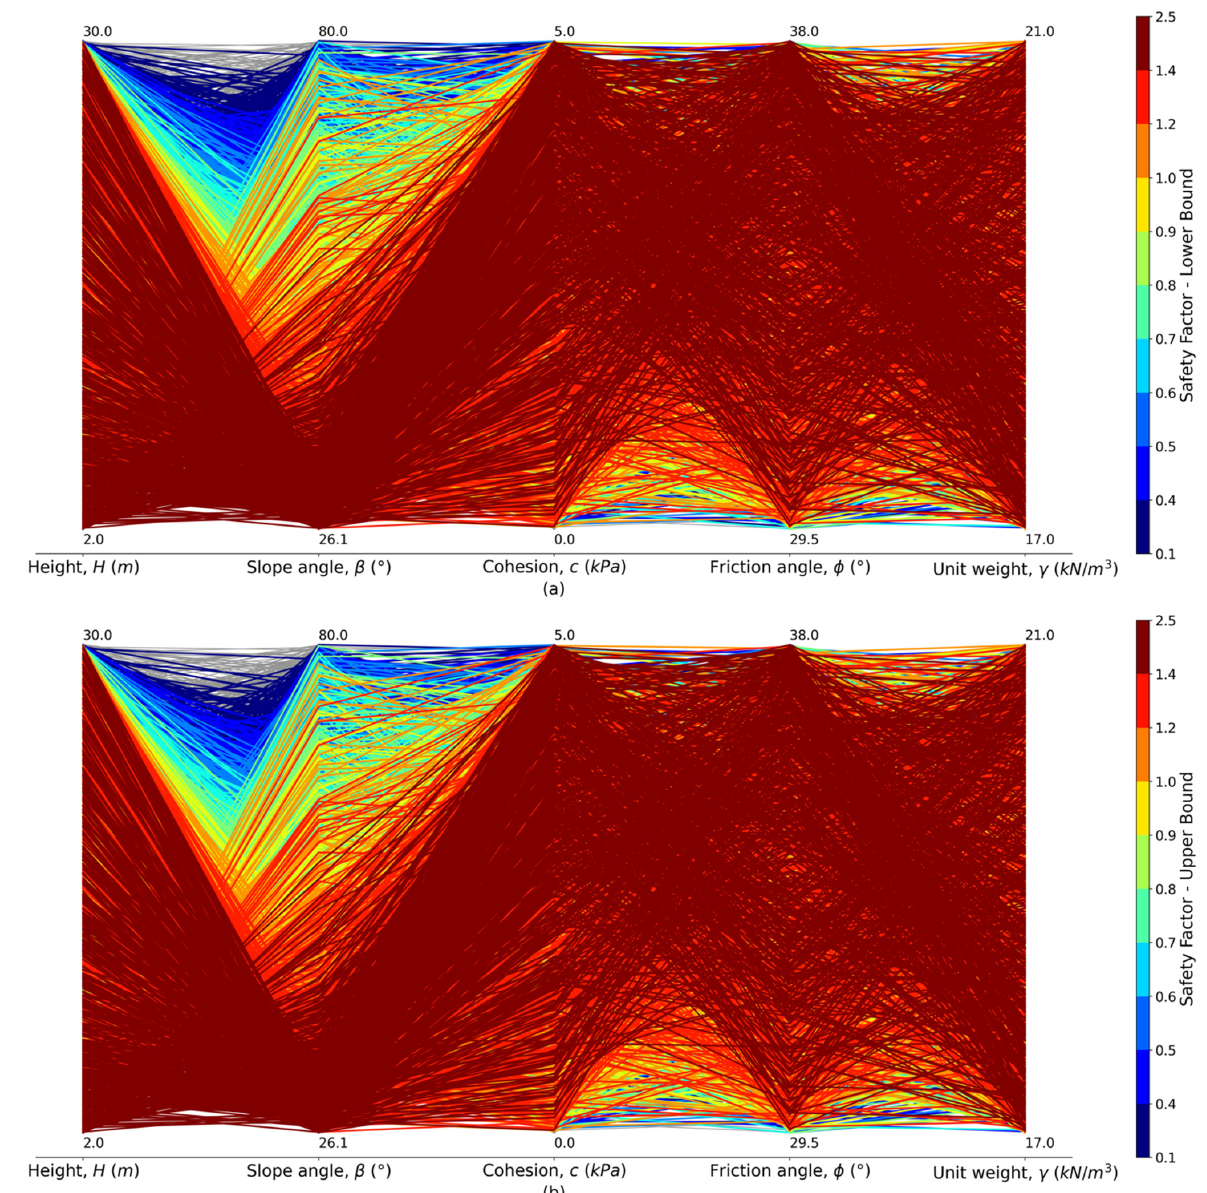
Figure 6. Parallel coordinates plot for ( a ) lower bound (SF-LB) and ( b ) upper bound (SF-UB) safety